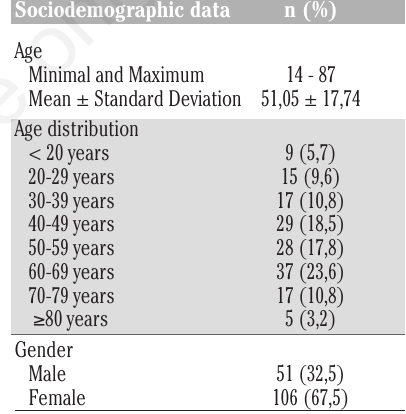
Table 1. Sociodemographic data of patients seen at the neurology outpatient clinic (n = 157).